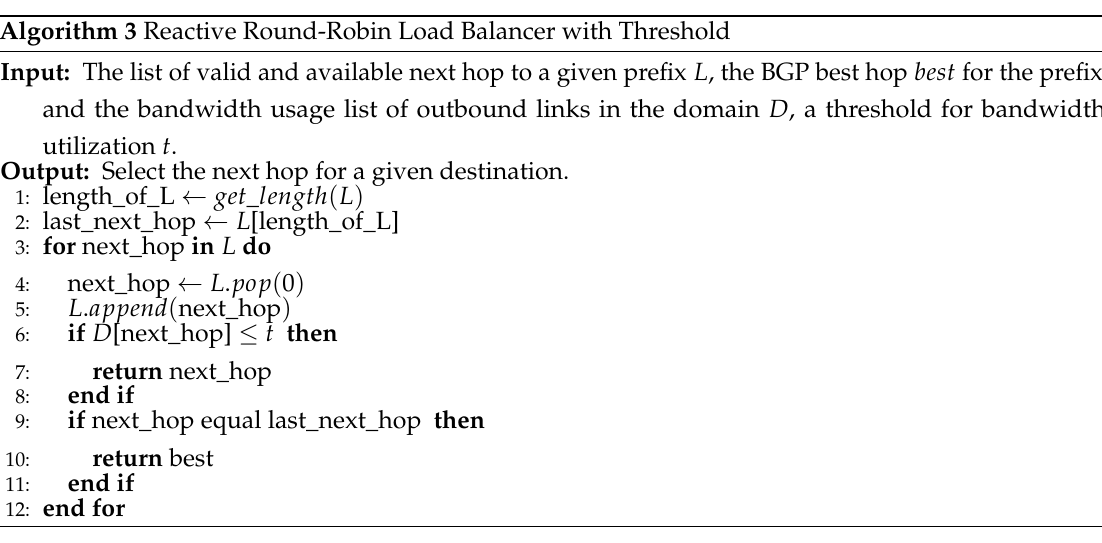
Algorithm 3 Reactive Round-Robin Load Balancer with